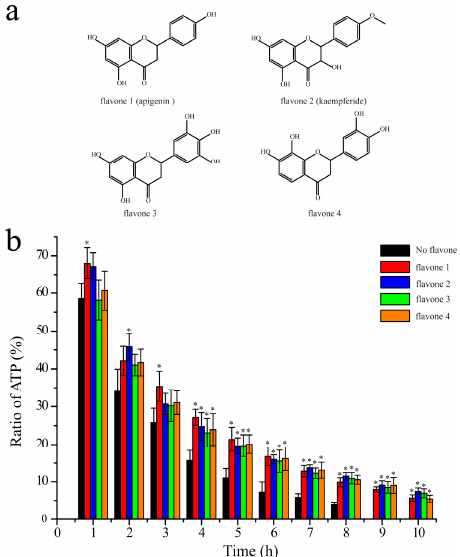
Figure 7. Inhibition of the autophosphorylation activity of HK853 cp by other flavones: ( a ) Chemical constructions of flavones 1, 2, 3, and 4; ( b ) the inhibition data are shown in red, blue, green, and orange for flavones 1, 2, 3, and 4, respectively (reaction conditions: 20 mM Tris, 50 mM KCl, 10 mM MgCl 2 , 8 mM ATP, 0.4 mM HK853 cp , and 0.8 mM flavone with 10% D 2 O, pH 7.0). The control group without flavones is colored in black ( n = 3, * p < 0.01 compared to the group without flavone).